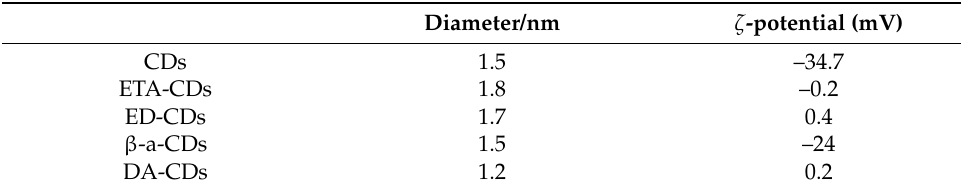
Table 1. Mean diameter and zeta potential of five carbon dots with different functionality in DDI